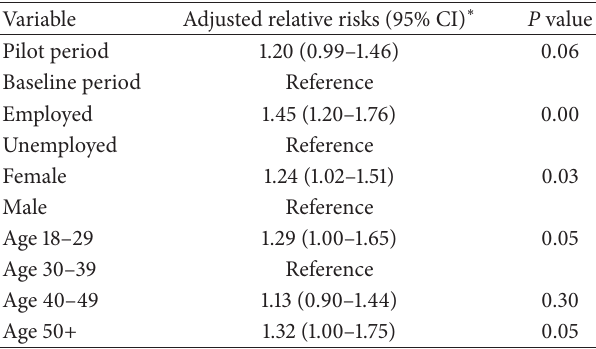
Table 2: Adjusted relative risks of initiating antiretroviral therapy within 16 weeks of HIV counseling and testing for patients with CD4 ≤ 250 on the day testing HIV-positive.